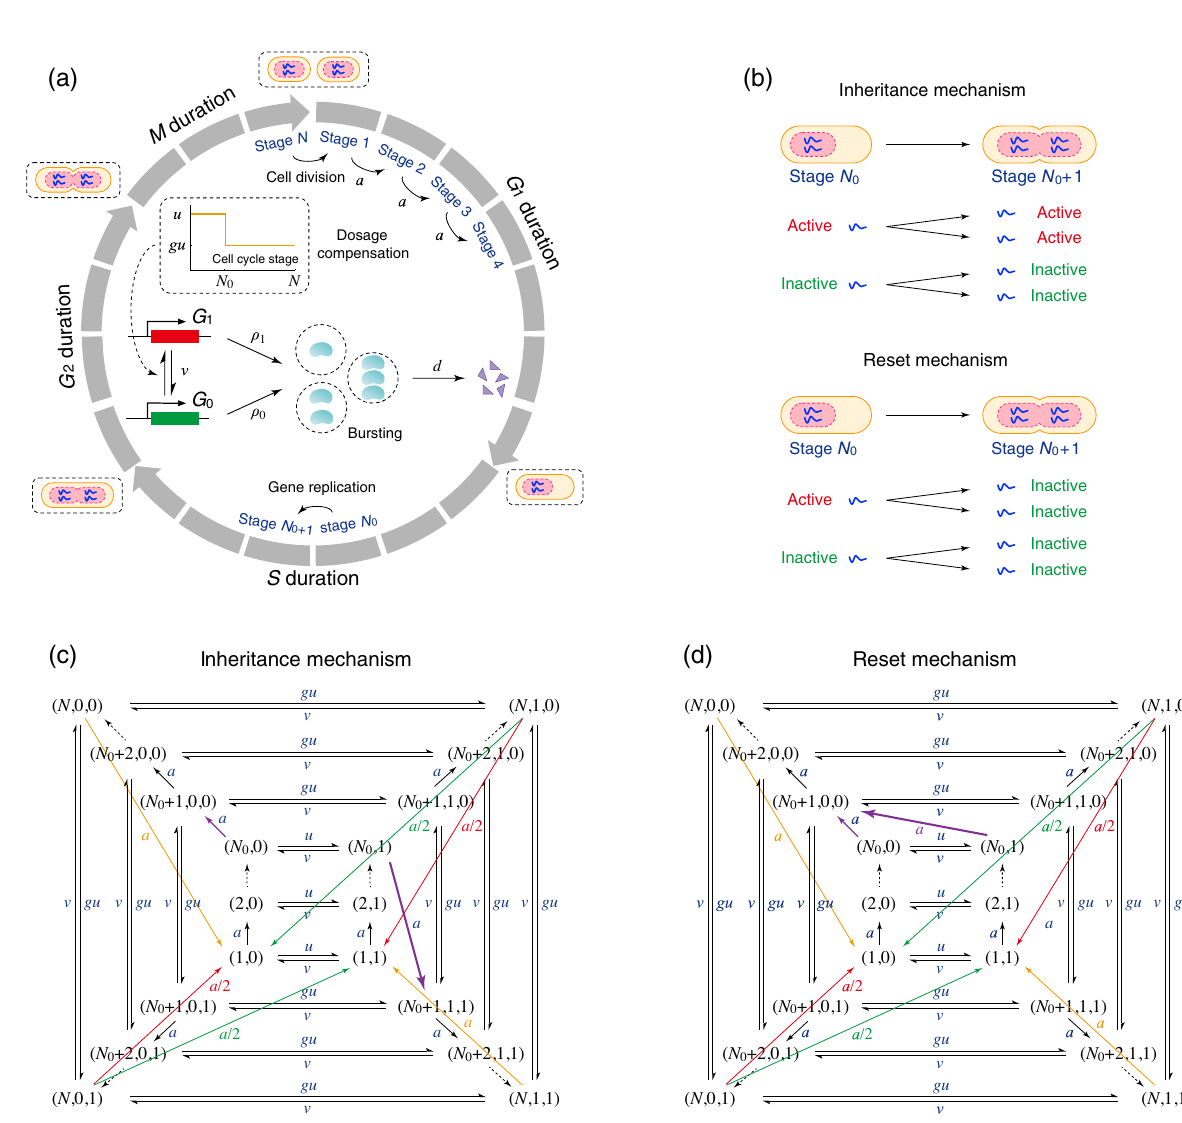
FIG. 7. The model with promoter switching. (a) Schematic illustrating the model describing N effective cell cycle stages, gene replication at stage N 0 , promoter switching between active (red) and inactive (green) states, bursty production of the gene product in the two gene states, degradation, and gene dosage compensation induced by a decrease in the activation rate of the gene after replication (see inset graph). (b) At replication, the gene states of the two daughter copies can be the same as that of the mother copy (inheritance mechanism) or else they are both reset to the inactive state (reset mechanism). (c),(d) Transition diagram of cellular states under the two mechanisms. Before replication, a cellular state can be represented by an ordered pair ð r; i Þ , where r is the cell cycle stage, and i is the gene state of the mother copy; after replication, a cellular state can be represented by an ordered triple ð r; i; j Þ , where i and j are the gene states of the two daughter copies. See the main text for explanation of the colored arrows. The difference between (c) and (d) is that the cellular state transitions from ð N 0 ; 1 Þ to ð N 0 þ 1 ; 1 ; 1 Þ in (c), while it transitions from ð N 0 ; 1 Þ to ð N 0 þ 1 ; 0 ; 0 Þ in (d) [see the arrows in (c) and (d) that are shown in